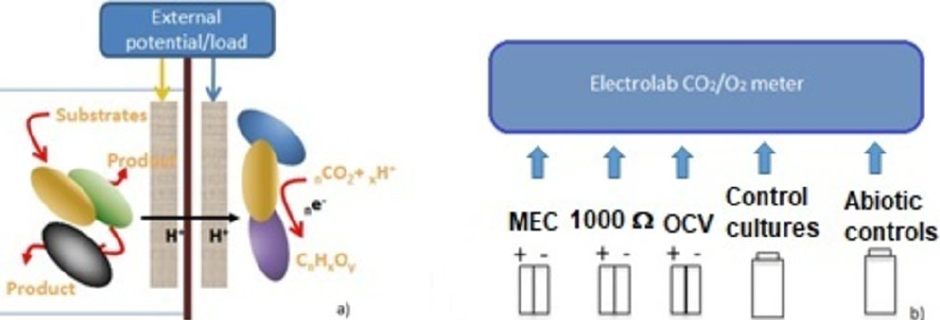
Figure 1. Experimental set-up. ( a ) Schematic representation of the processes occurring at the electrode of MFCs and MECs used in our research. ( b ) MFCs and MECs and controls used for CO 2 capture testing.